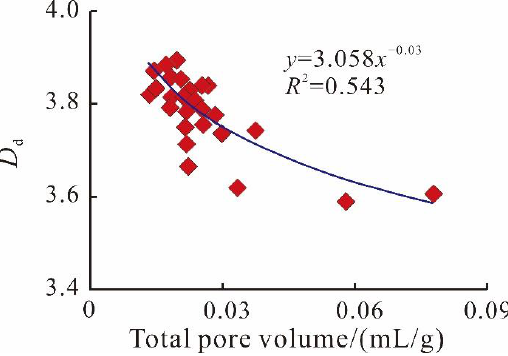
Figure 9. Relationship between total pore volume and percolation fractal dimension ( D p ).